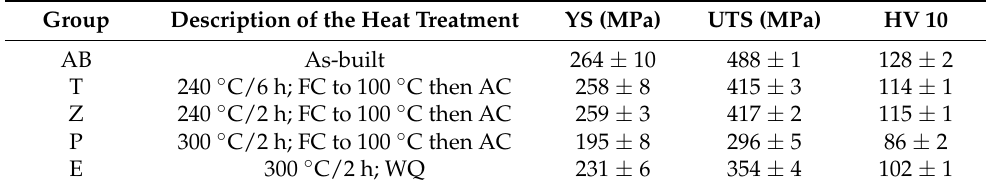
Table 6. Mechanical properties of L-PBF AlSi10Mg at different stress relief annealing modes compared to an as-built state.